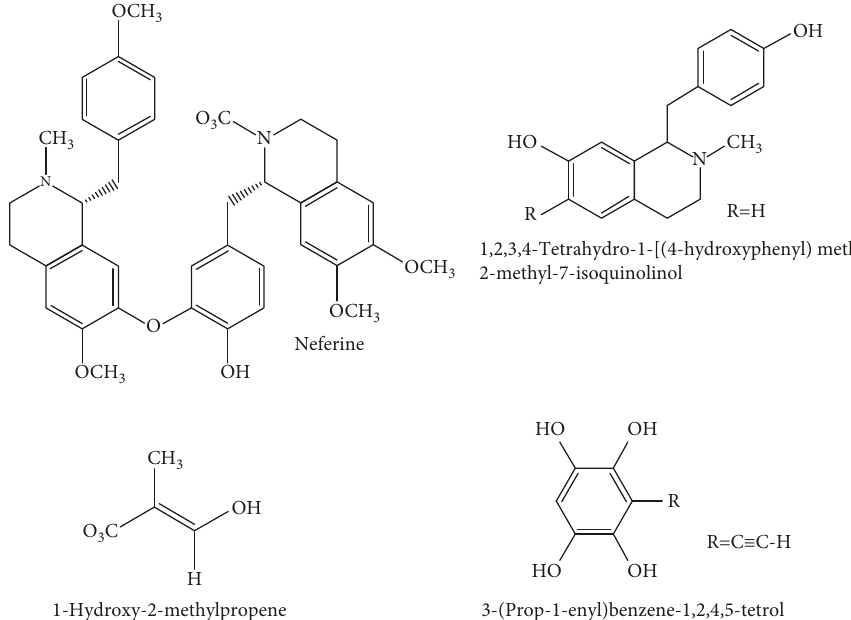
Figure 1: Chemical structures of compounds in N. nucifera